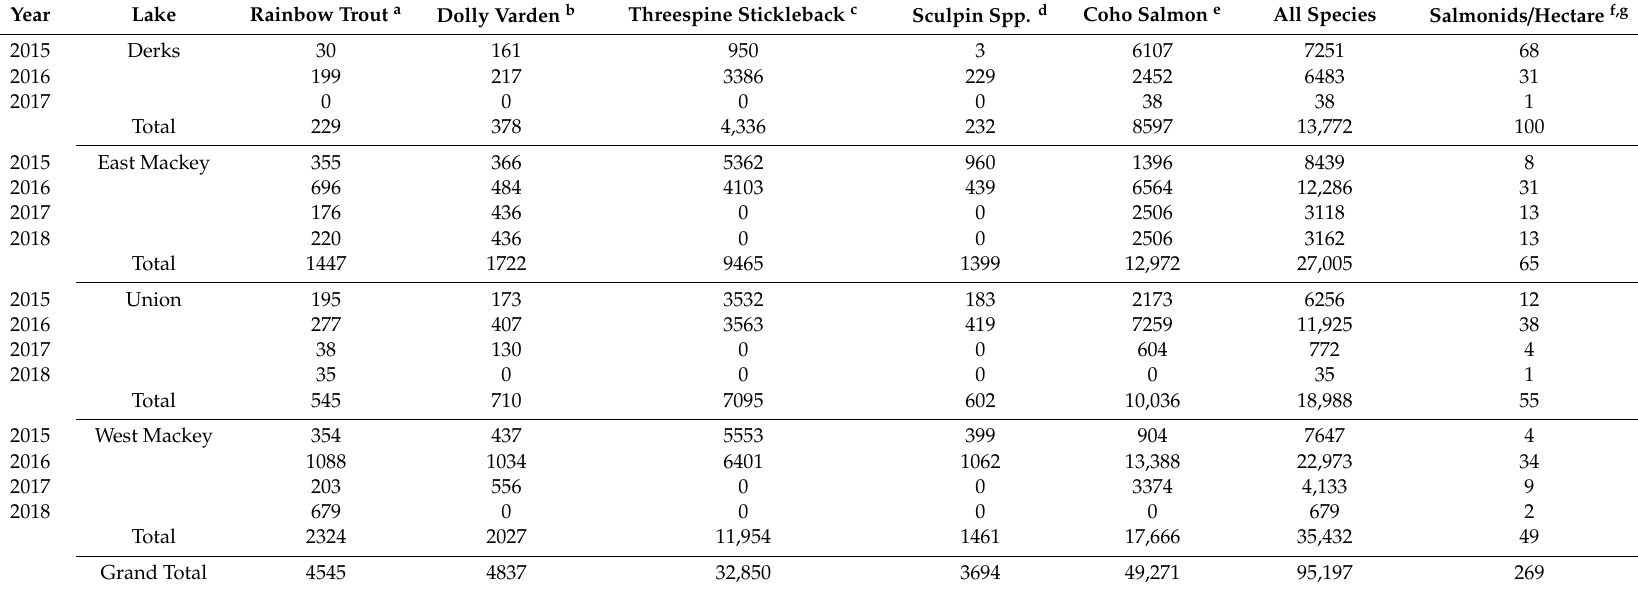
Table 2. Native fish released into Soldotna Creek Pike Eradication Area 1 lakes during